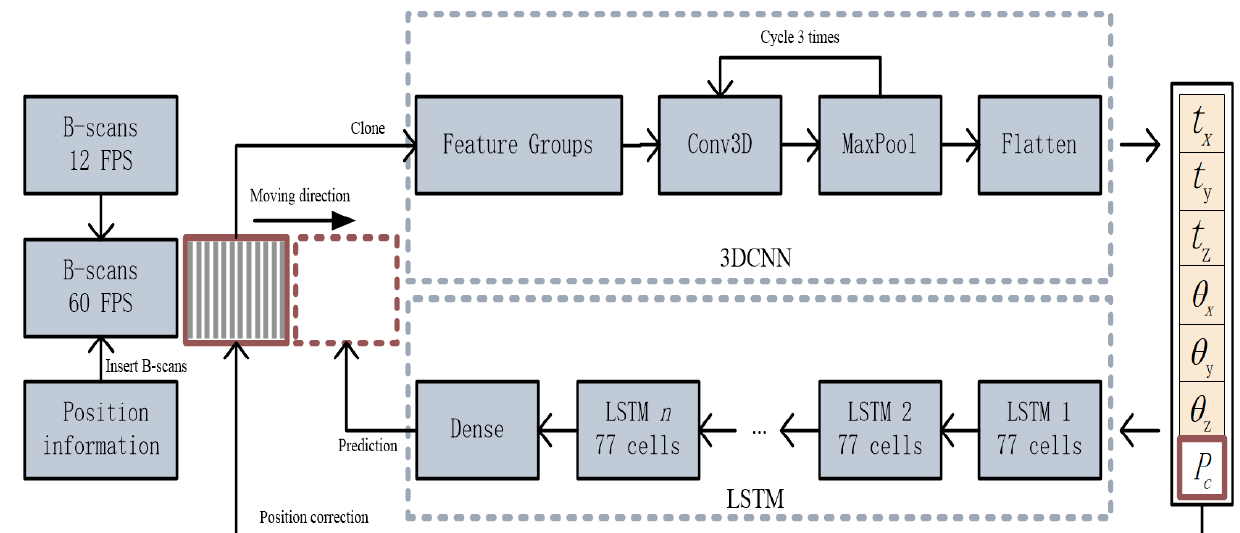
Figure 7. Hybrid model of 3DCNN-LSTM network.